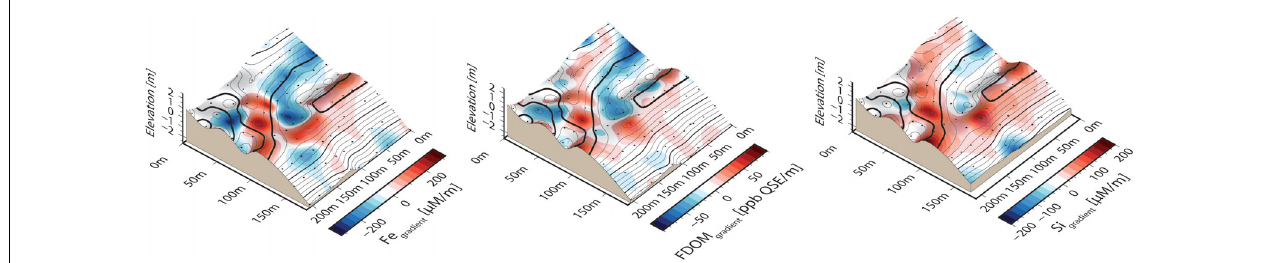
FIGURE 7 | Concentration gradients for Fe(II), FDOM, and DSi from the August 2017 campaign. Warm colors indicate infiltration zones (conc 100 cm > conc 50 cm ), cool colors indicate exfiltration zones (conc 100 cm < conc 50 cm ).